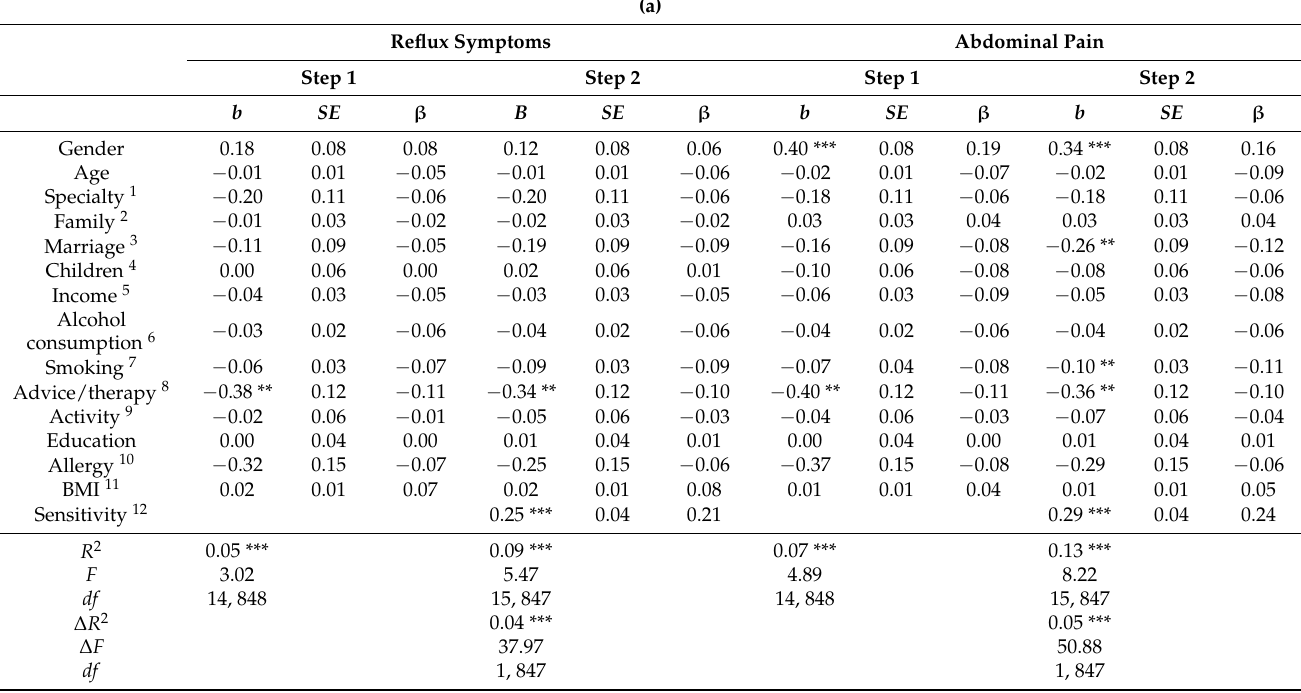
Table 3. (a). Regression Models Predicting Gastrointestinal Symptoms (Reflux Symptoms and Ab- dominal Pain). (b). Regression Models Predicting Gastrointestinal Symptoms (Indigestion Symptoms and Diarrhea Symptoms). (c). Regression Models Predicting Gastrointestinal Symptoms (Constipa- tion